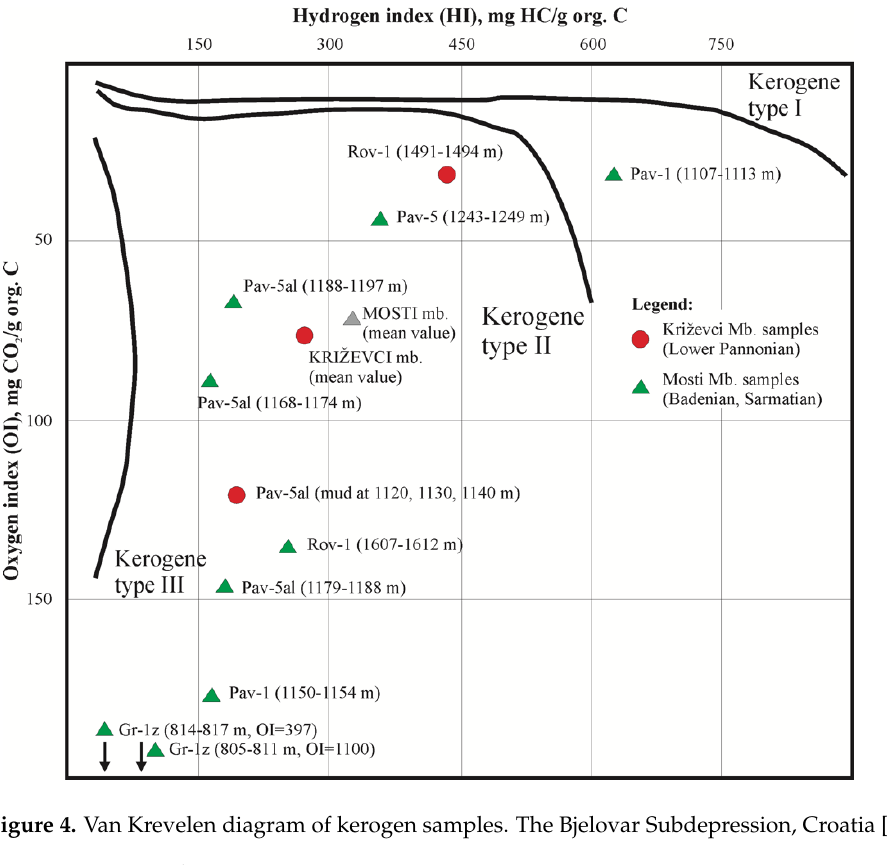
were activated in the last 0.2 Ma [16]. Moreover, generation in leaner source rocks is a less